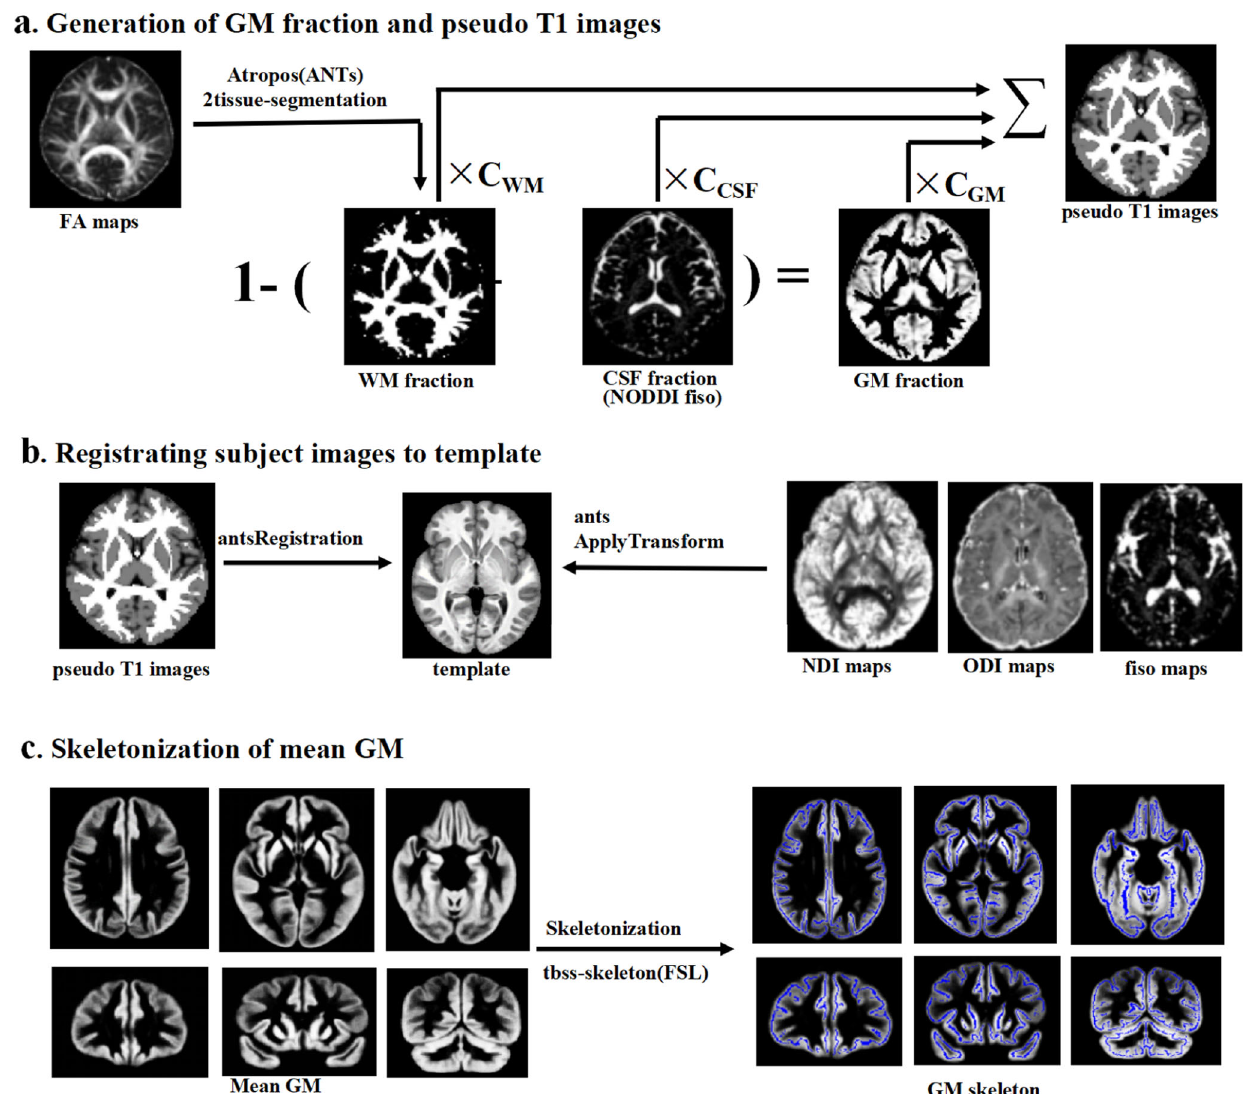
Fig. 4 Processing steps of GBSS. a GM fraction maps were generated by subtracting the WM fraction (estimated by two-tissue class segmentation of resampled FA maps using Atropos segmentation tool) and the CSF fraction (resampled f iso maps from NODDI) from one. The GM, WM, and CSF fraction were used to generate pseudo T1-weighted images. b Pseudo T1-weighted images from all subjects were registered to the OASIS-30_Atropos_template and all resampled NODDI maps and GM fraction maps were aligned to the template. c GM fraction images from all subjects were averaged to generate mean GM images, which were skeletonized using FSL ’ s tbss_skeleton tool. All NODDI parameters maps and GM fraction maps were projected onto this GM skeleton. GBSS gray matter-based spatial statistics, GM gray matter, WM white matter, FA fractional anisotropy, CSF cerebrospinal fl uid, NODDI Neurite Orientation Dispersion and Density Imaging, NDI neurite density index, ODI orientation dispersion index, f iso volume fraction of isotropic diffusion, FSL FMRIB Software